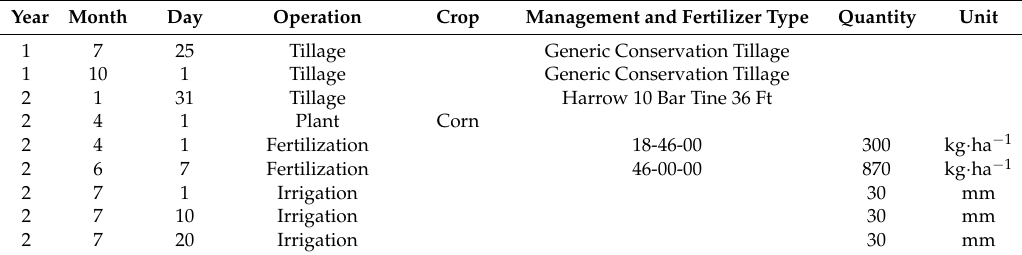
Table 2. Crop rotations applied in the agricultural